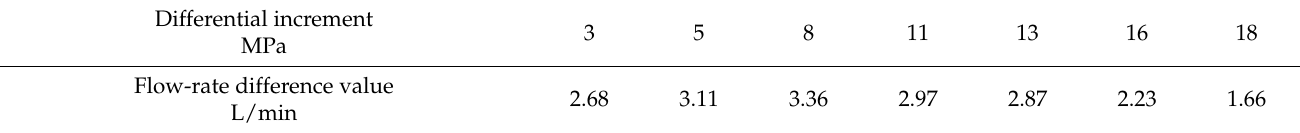
Table 2. Corresponding relationship between flow-rate difference and differential pressure